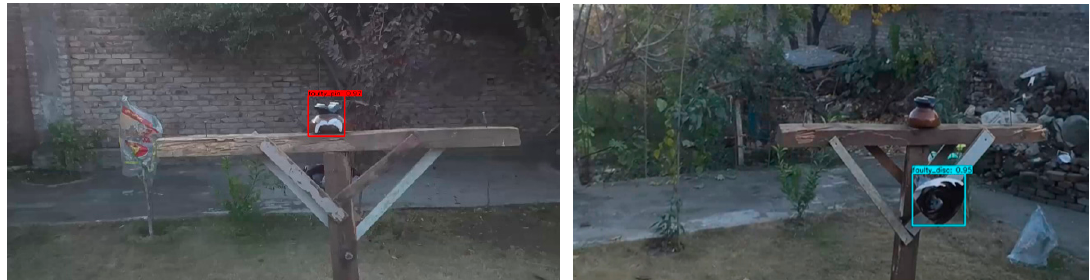
Sensors 2021 , 21 , x FOR PEER REVIEW 24 of 25 Figure A4. Test results. Row 1, left: YoloV4. Row 1, right: YoloV5x. Row 2, left: YoloV4 Tiny. Row 2, right: YoloV5s.